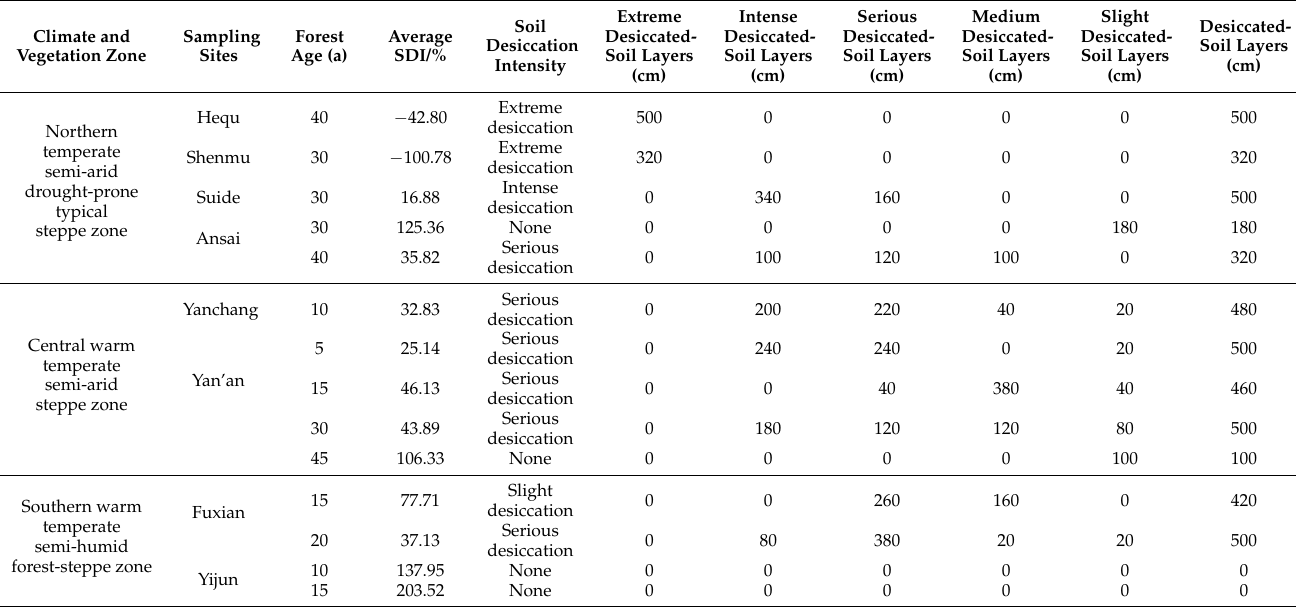
Table 6. Evaluation of soil-desiccation intensity and thicknesses of desiccated-soil layers under R. pseudoacacia